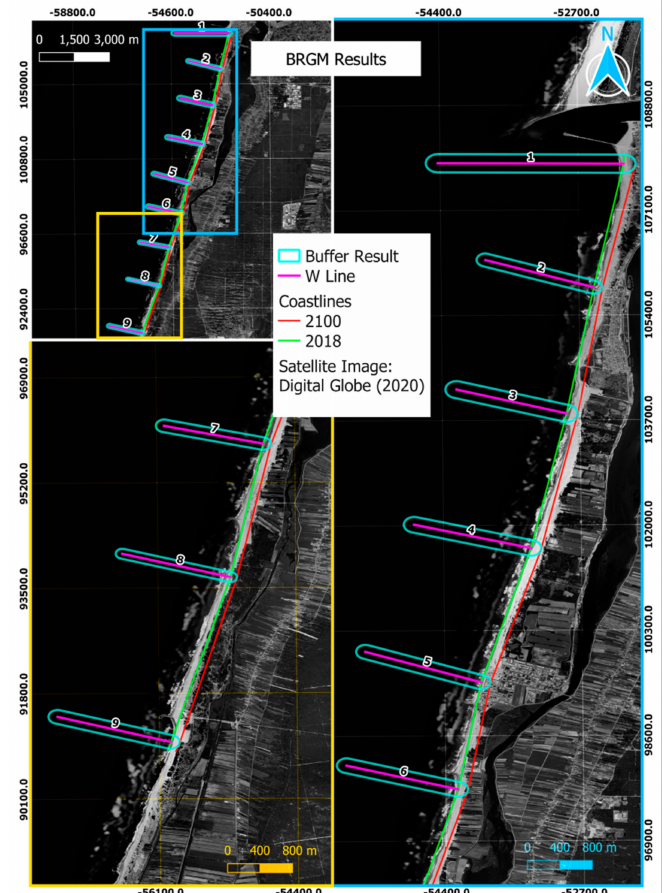
Figure 10. Results of Bruun rule by the year 2100 with the projection RCP 8.5 AIS 60 cm (1.21 m). Table 2018. and the red line the expected position in 2100.